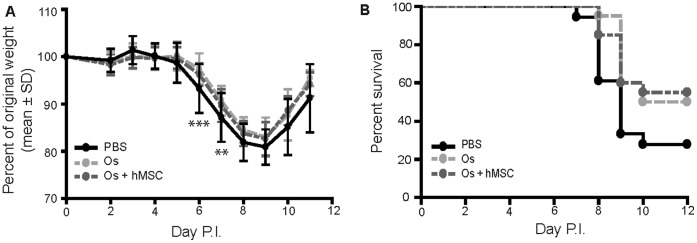
hMSC adjunctive therapy failed to alter weight loss or improve survival compared to antiviral therapy alone in experimental severe influenza.Eight-week old male C57Bl/6 mice infected with 425 EID50 influenza A/PR/8 virus were administered 2.5 mg/kg oseltamivir in 100 ul ddH2O via gavage, 1×daily for 5 days, beginning day 2 P.I., with or without hMSC administration (5×105 cells) on day 2 P.I. (A) Weight loss kinetics over the course of infection were measured to assess morbidity in mice. Oseltamivir treated mice had significantly decreased weight loss compared to control mice on day 6 and day 7 P.I. (two-way ANOVA with Bonferroni post-tests, ***p<0.001, **p<0.01, n = 18–20/group; 2 pooled experiments). No difference in weight loss was observed between mice administered oseltamivir and hMSCs in combination compared to mice administered oseltamivir alone. Error bars represent standard deviation. (B) Survival curve. Mice administered oseltamivir were trending towards increased survival compared to the control group administered ddH2O; however, no difference was observed between mice administered oseltamivir and hMSCs in combination compared to mice administered oseltamivir alone (logrank test, n = 18–20/group; 2 pooled experiments). Os = oseltamivir.